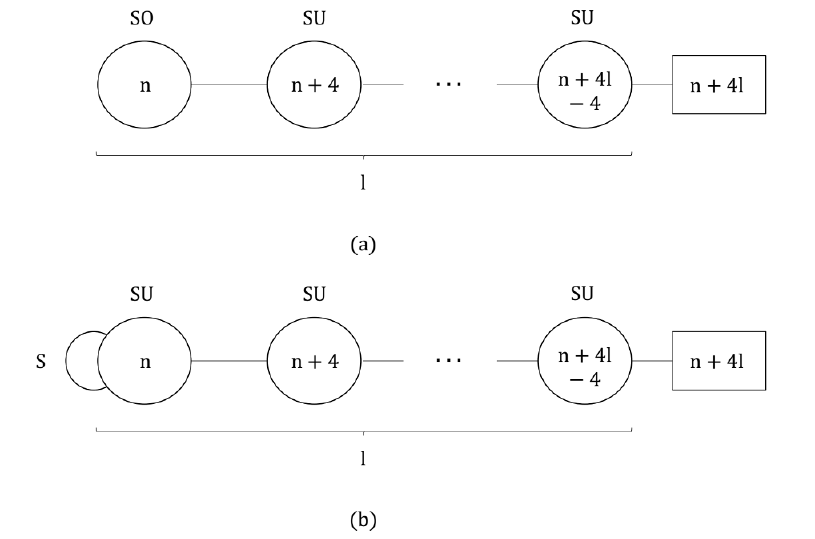
Figure 4 . Quivers of the 4 d gauge theory that is expected to exist, on a generic point on the Coulomb branch spanned by the operators descending from the tensor multiplets, for theories resulting from the Stiefel-Whitney compacti(cid:12)cation of the theories in (cid:12)gure